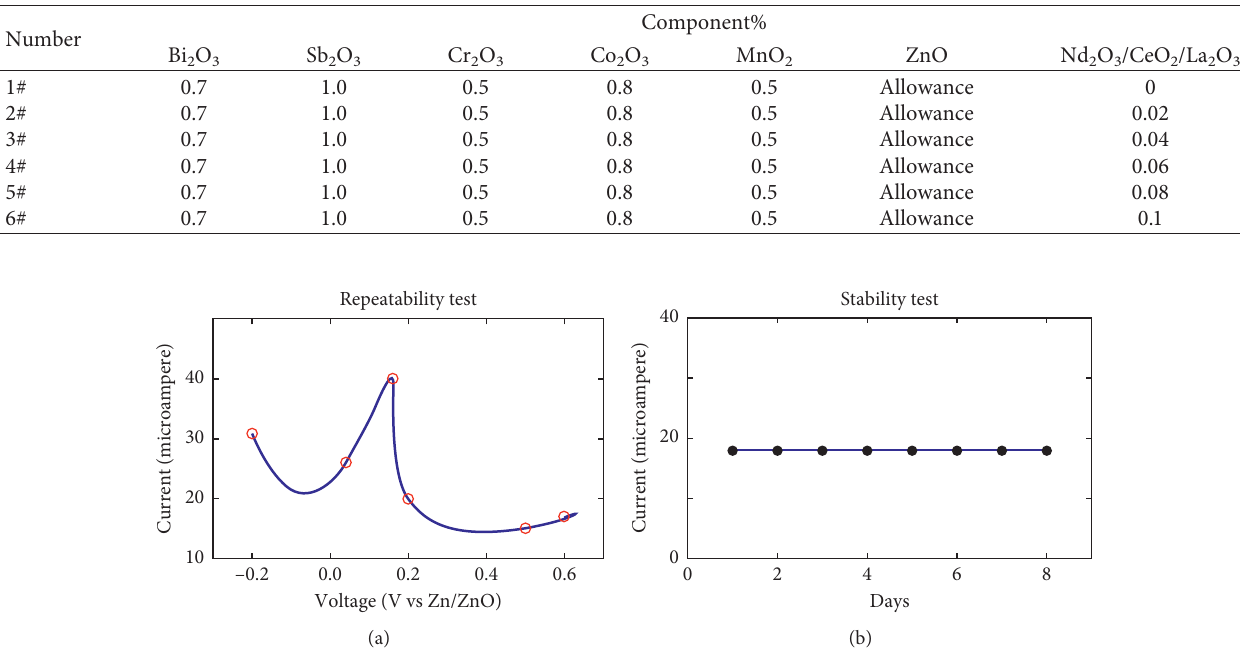
Figure 2: Repeatability and stability of graphene/ZnO nanomaterials/ITO electrodes. Table 2: Conductivity of samples with different holding time. Holding time